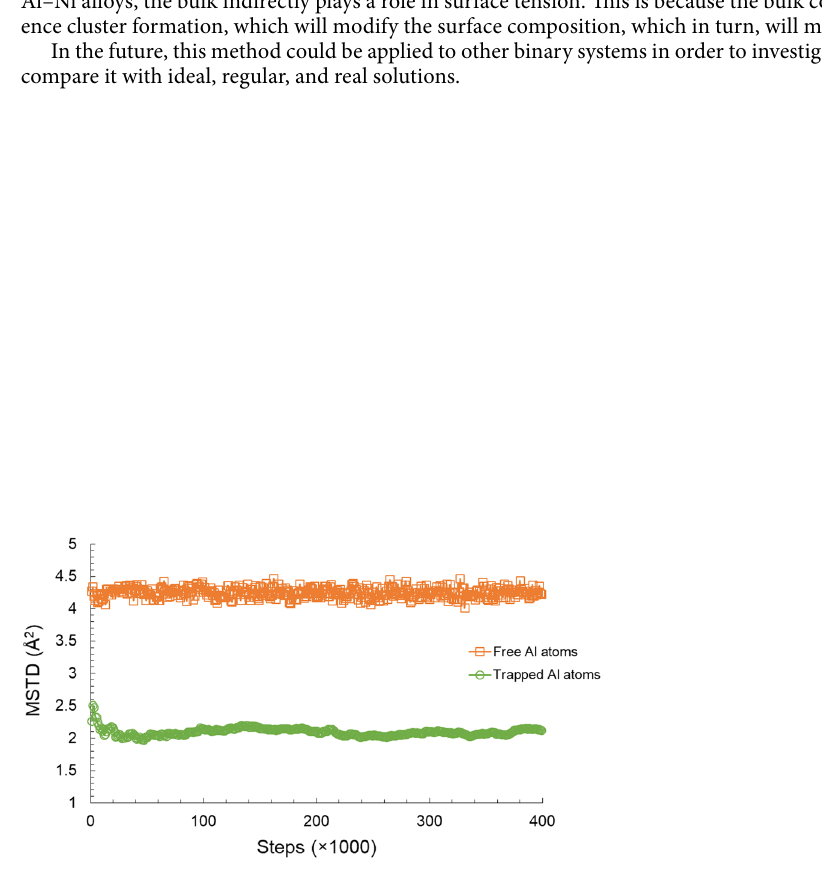
Figure 13. MSTD of free and trapped Al atoms at Al–0.5Ni